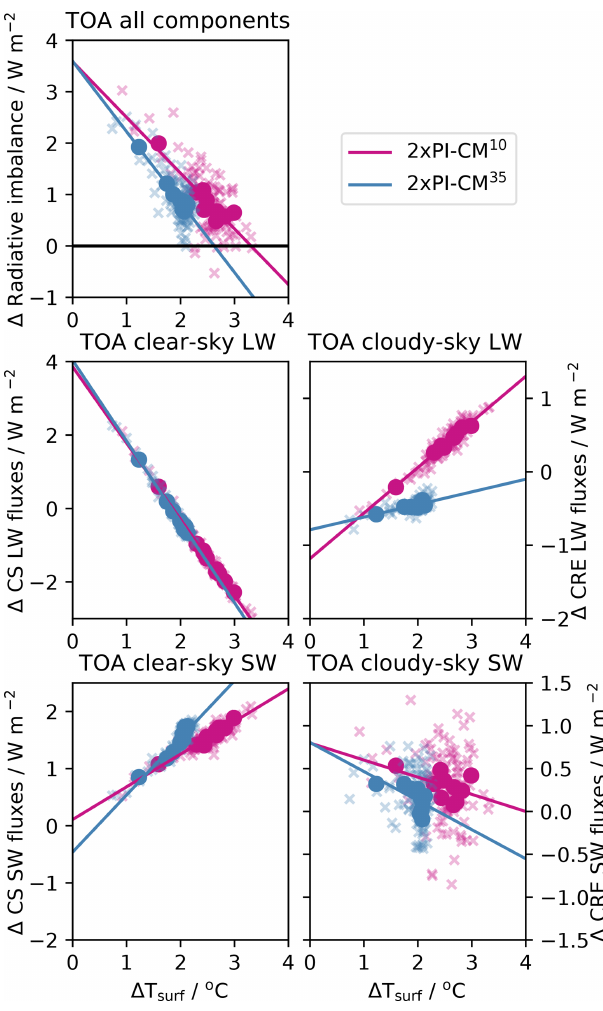
Figure 10. Gregory analysis of HadCM3-BL: regression of top- of-atmosphere radiative imbalance against surface air temperature change (solid lines) for the first 100 years of 2 × As-CM 10 (pink) and 2 × As-CM 35 (blue) cases. Annual averages are indicated by crosses and decadal averages are indicated by filled circles. The re- gression was performed on the decadal